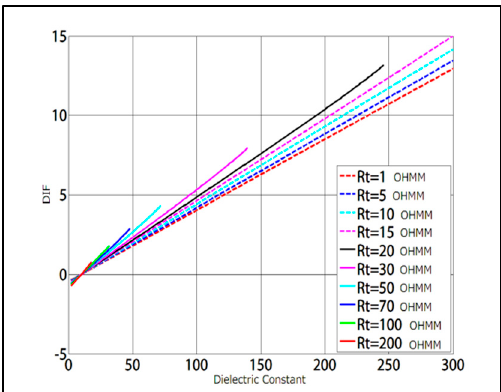
Figure 5. Characteristics of curve separation coe ffi cient changing with resistivity.